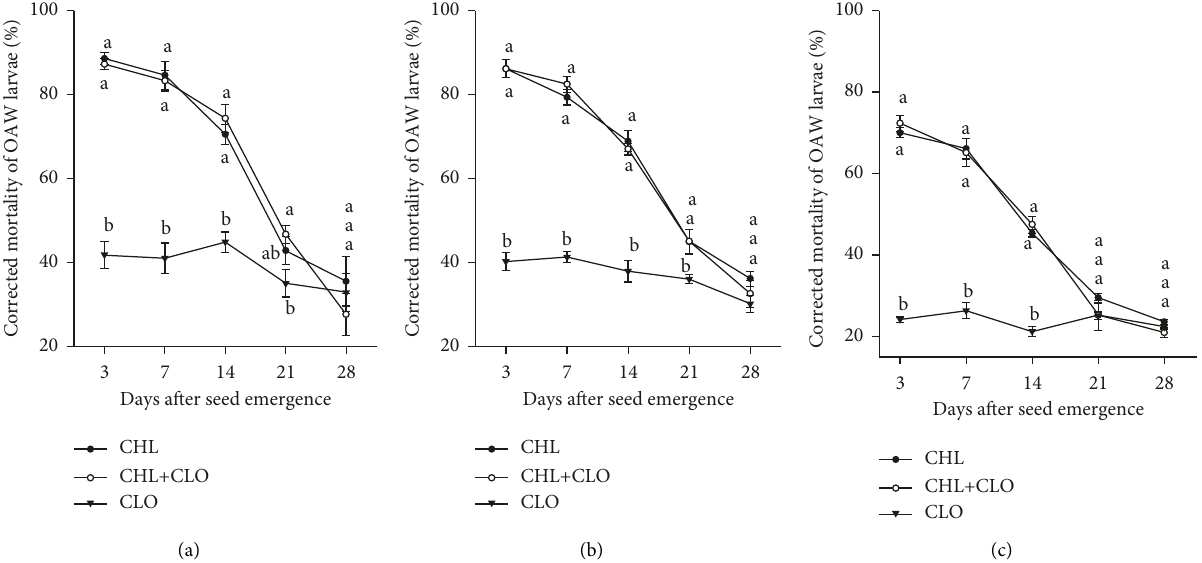
Figure 2: Mortality of OAW larvae fed on field-grown plants treated with CHL, CHL+CLO, and CLO. Panels show mortality for 2 nd (a), 3 rd (b), and 4 th (c) instar larvae. CHL, chlorantraniliprole; CHL +CLO, chlorantraniliprole+clothianidin; CLO, clothianidin. Data are analyzed using one-way ANOVA followed by Tukey’s test at each sampling date, and different letters indicate significance at P < 0 . 05. Table 2: Control efficiency and growth indices of corn seedlings treated with CHL, CHL +CLO, and CLO in the field ∗ .